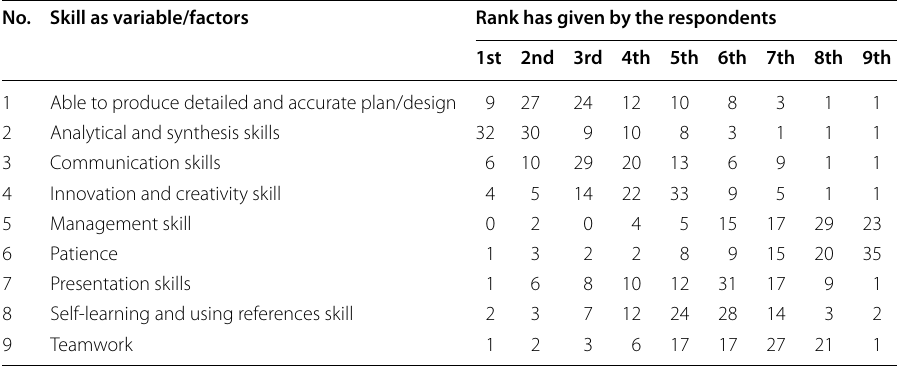
Table 2 Preference and ranking of planners skills by the respondents No. Skill as